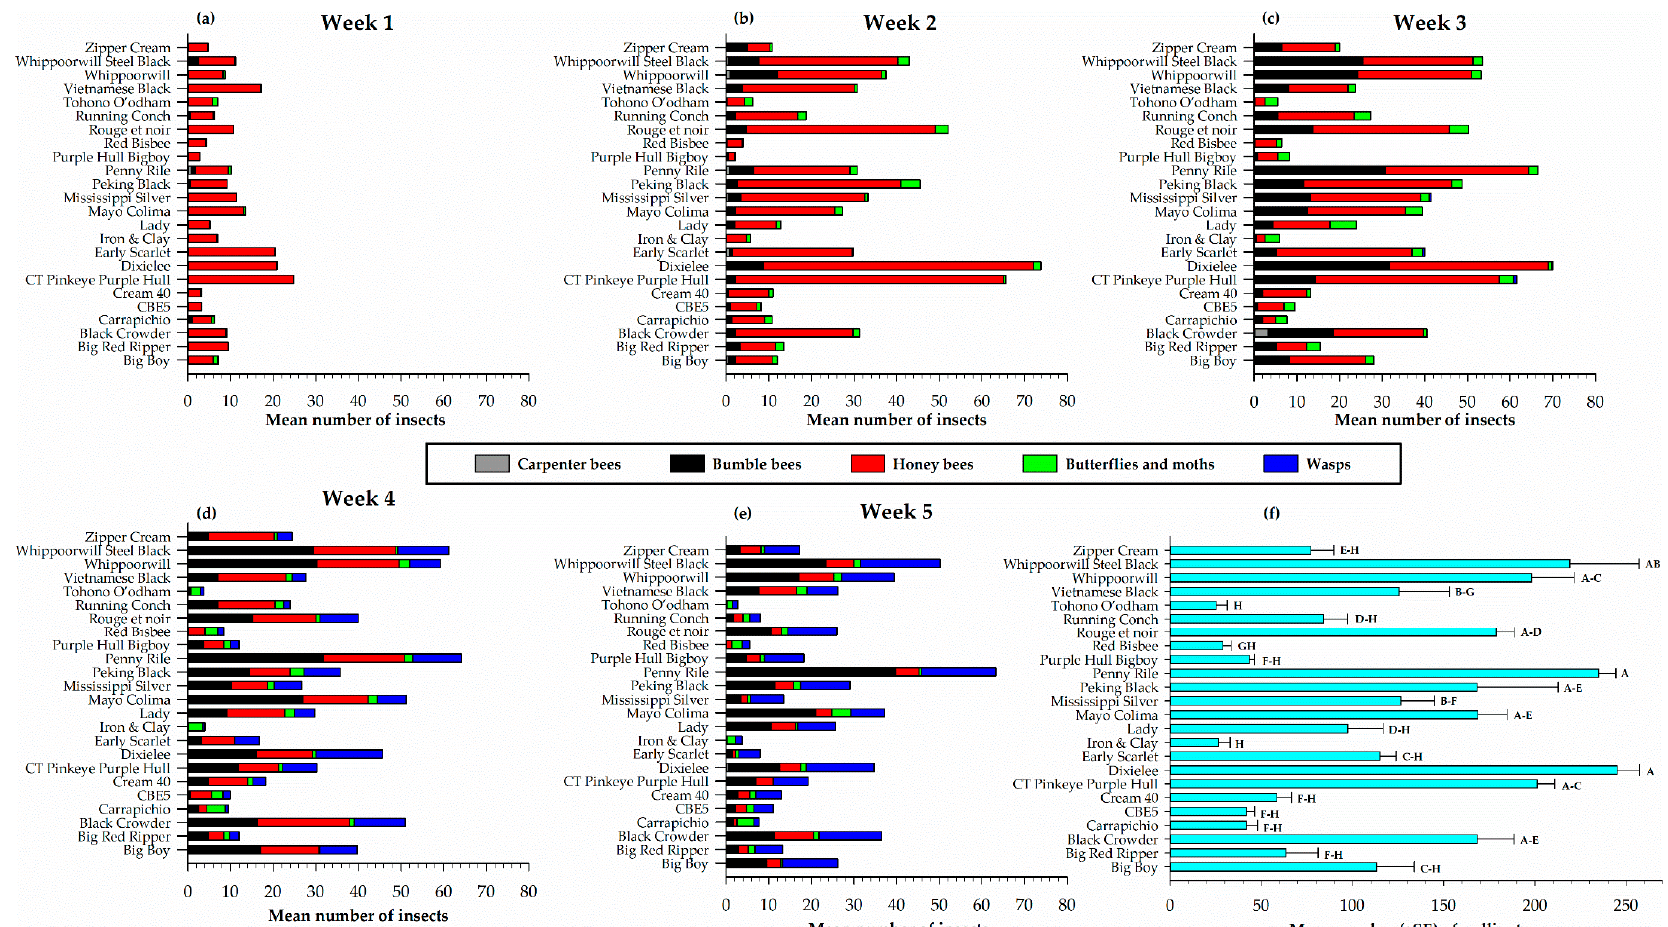
Figure 4. Weekly distribution of pollinator groups ( a – e ) and total number of pollinators ( f ) on different cowpea varieties through direct visual counts. In Figure 4f, mean numbers followed by the same letters are not significantly different ( p > 0.05)